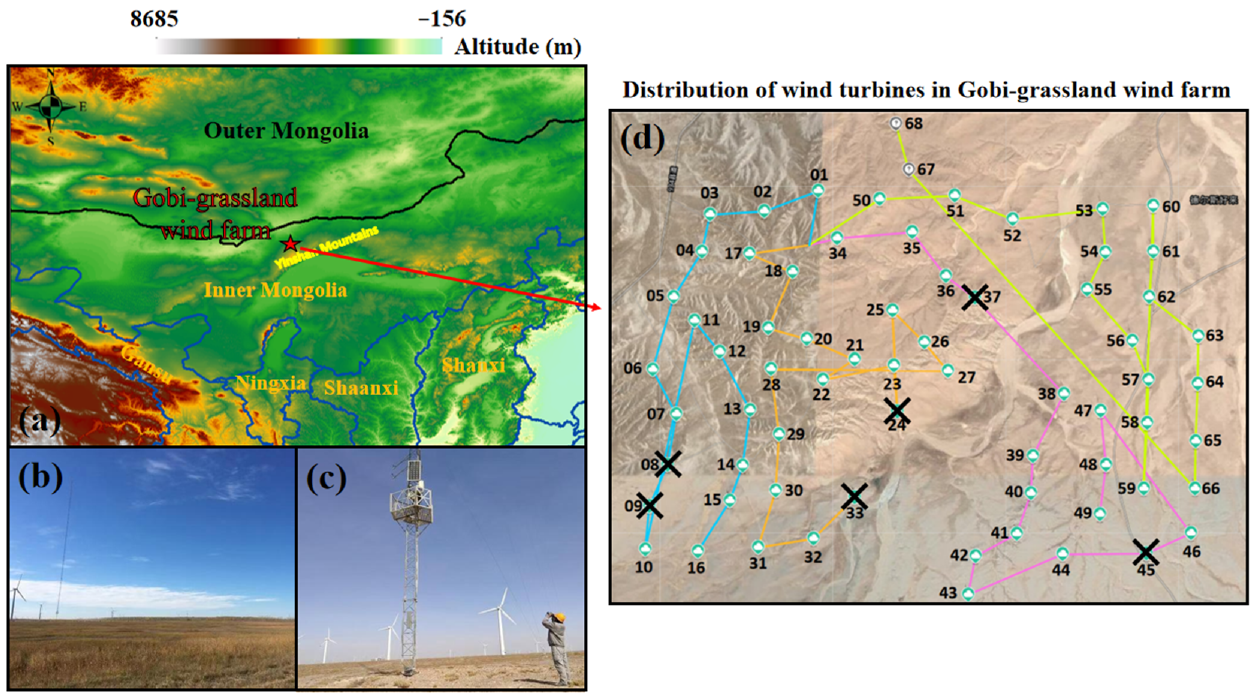
Figure 1. The geophysical location ( a ), pictures ( b , c ), and distribution of wind turbines ( d ) of the Gobi grassland wind farm. Symbol “X” in ( d ) denotes the turbines out of service now and the different colored lines represent the turbines group built in different time.